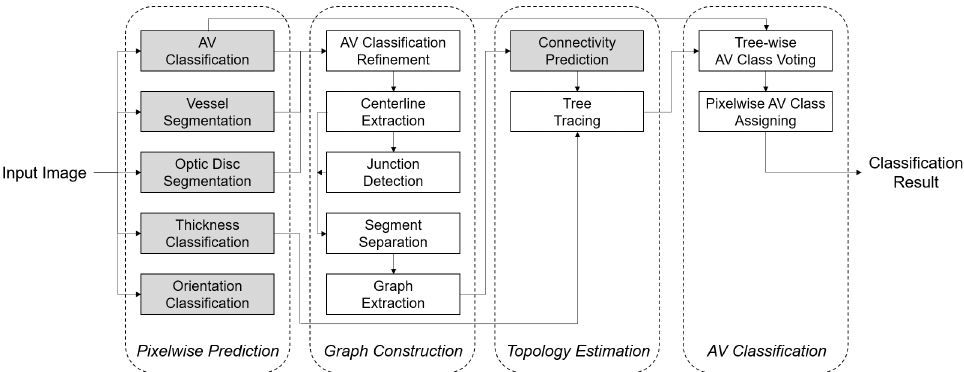
Figure 2. Block diagram of the proposed method for AV classification at test time. Pixelwise prediction on the optic disc and vessel, graph construction, topology estimation, and the final AV classification are sequentially performed. Each block is also composed of several parallel or sequential steps. The arrows denote information flow. Gray-color boxes represent steps where the trained networks are involved. The thickness/orientation classifications are auxiliary tasks for the connectivity classification, and their relationship is not represented here. Please refer to the corresponding sections for